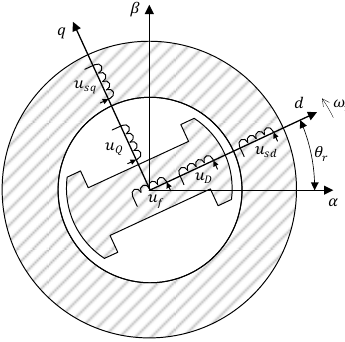
Figure 1. Salient pole synchronous machine model in the rotor reference frame.